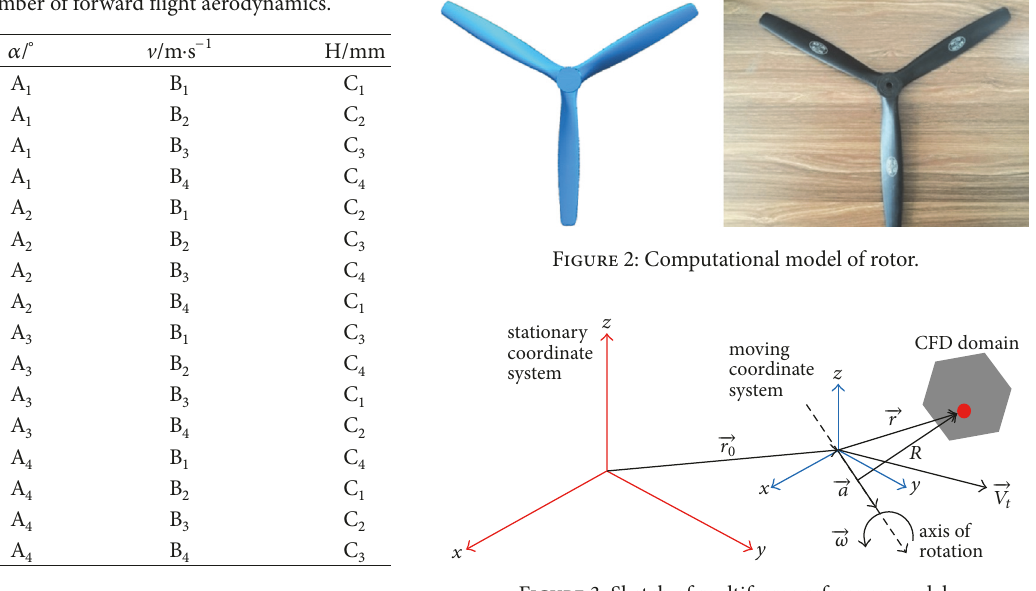
Figure 3: Sketch of multiframe reference